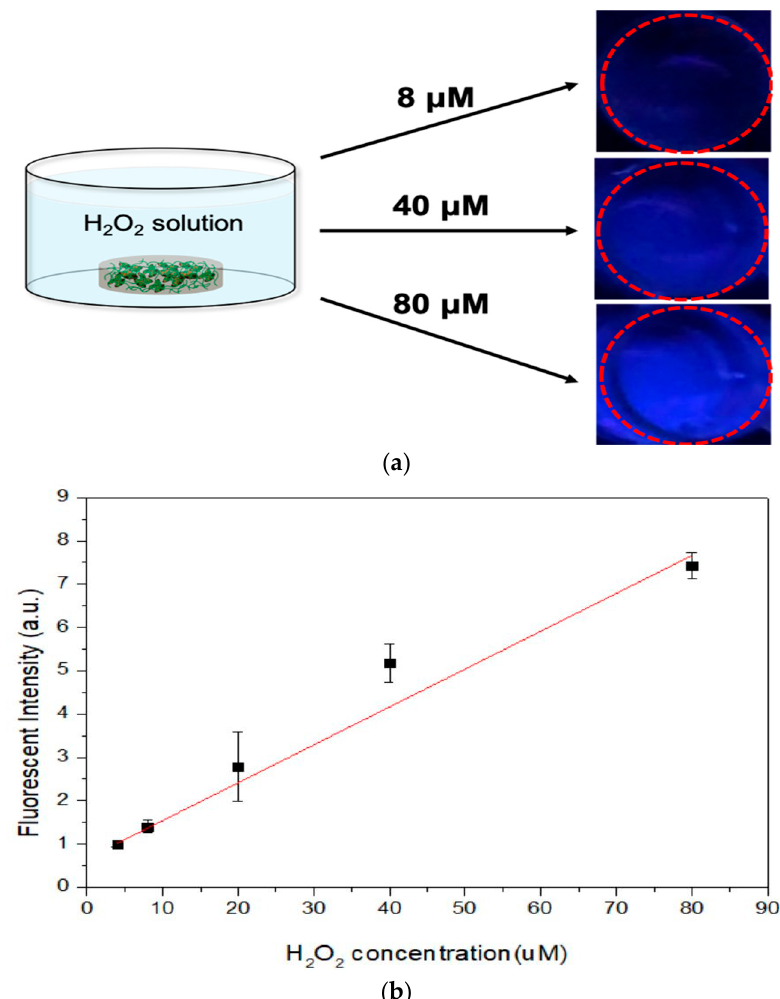
Figure 5. ( a ) Images of increasing blue fluorescent intensities of supernatants. Images of the fluorescence (marked in red circles) increased with increasing H 2 O 2 concentrations (e.g., 8, 40 and 80 µ M) in solutions, ( b ) The normalized blue fluorescent intensities after GDES films fully scavenged H 2 O 2 were linearly increased with increasing H 2 O 2 concentration from the range of 4.0 to 80 μ M (Data are mean ± SD, n = 3; R 2 = 0.984).